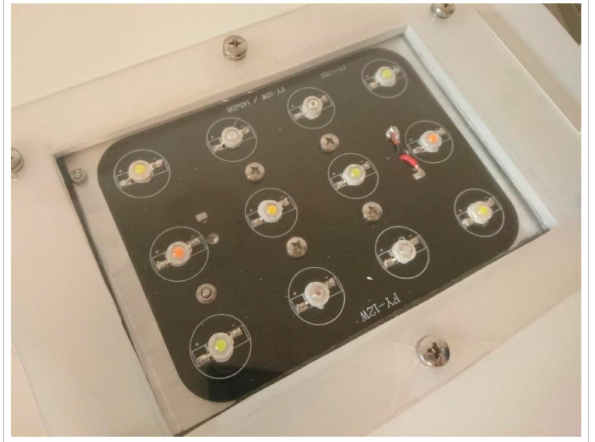
Figure 9. Lighting unit bottom side – LEDs soldered onto a PCB (printed circuit board) plate.